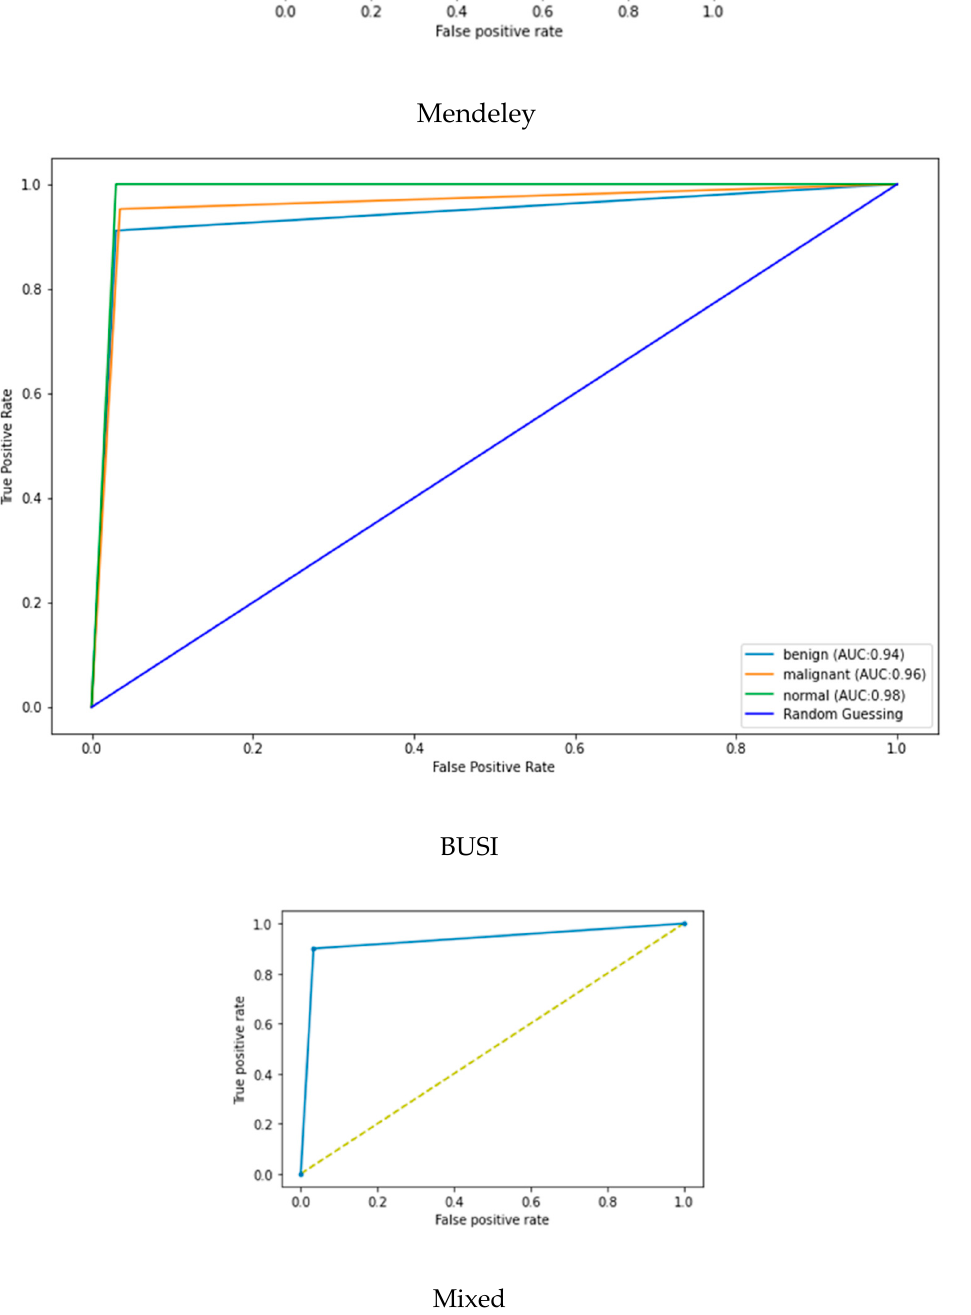
Figure 7. Receiver operating characteristics (ROC) curves of the proposed method on Mendeley, BUSI, and mixed datasets. BUSI, breast ultrasound image dataset.